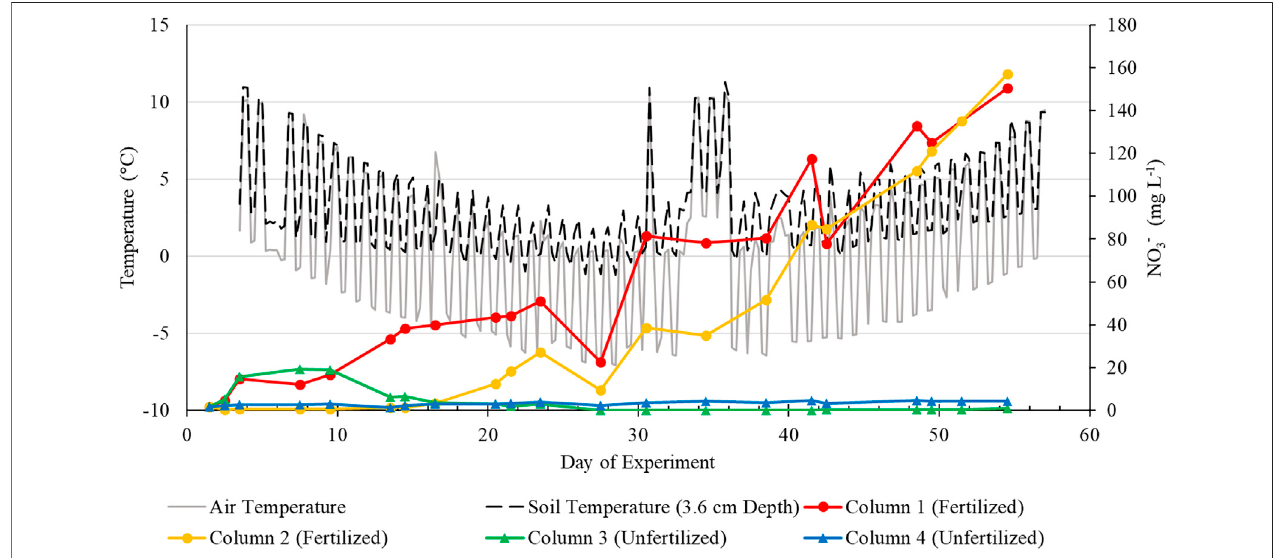
FIGURE 5 | Temperature and leachate NO 3 − concentrations versus time for fertilized and unfertilized columns.